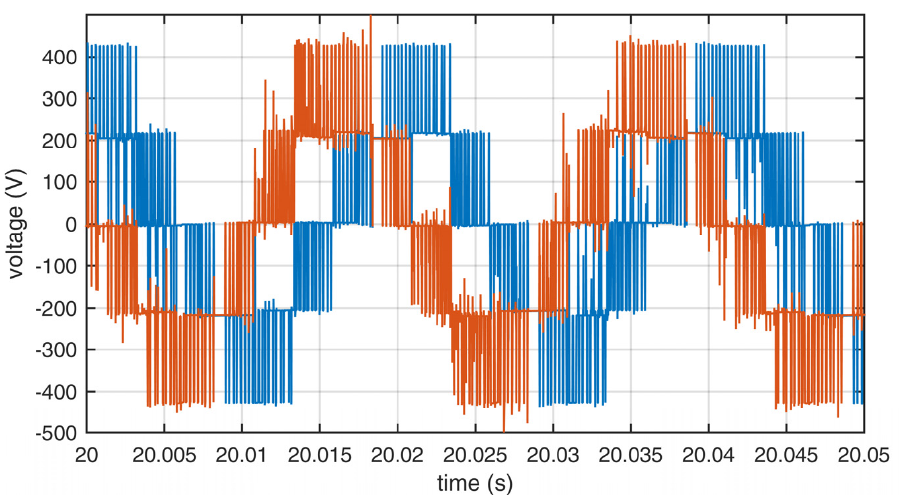
Figure 8. Output line voltages of the inverter using set A. Blue—L1, red—L2.